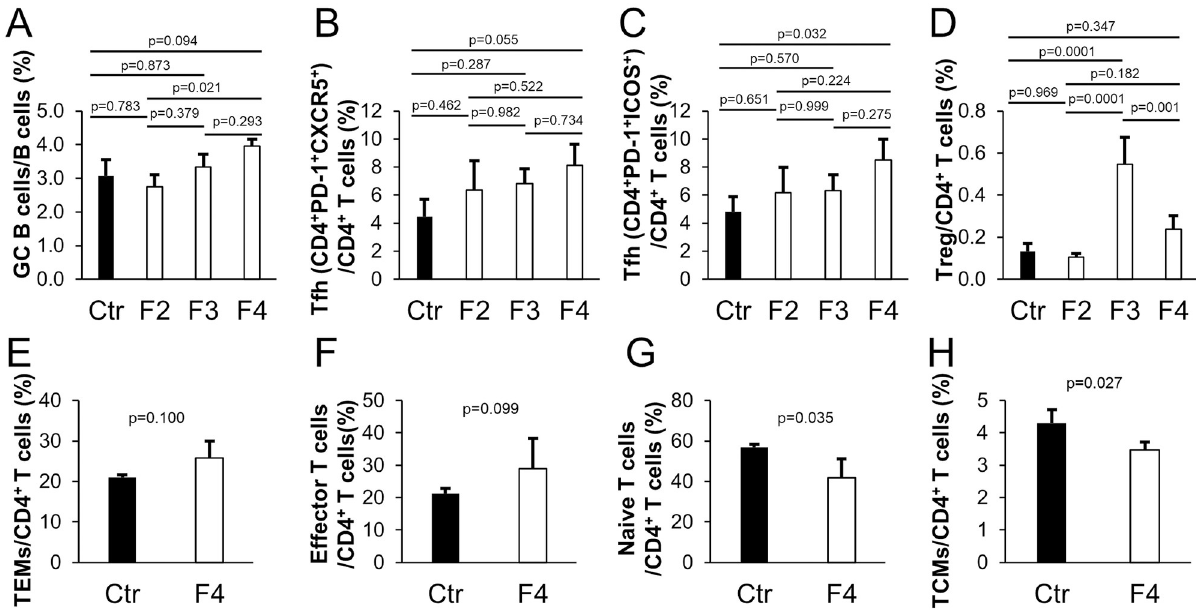
Fig 2. Intergenerational effects of T . halophilus No. 1 on B cells and T cells. We examined the proportion of B cell and T cell subsets in mice spleen. Flow cytometry plots are depicted in S3 Fig. (A) The proportion of GC B cells (B220 + GL7 + ) among B cells. (B) The proportion of Tfh cells (CD4 + PD- 1 + CXCR5 + ) among CD4 + T cells. (C) The proportion of Tfh cells (CD4 + PD-1 + ICOS + ) among CD4 + T cells. (D) The proportion of Treg cells (CD4 + CD127 − CD25 + CTLA4 + ) among CD4 + T cells. In (E)–(H), the proportion of subsets of CD4 + T cells in the F4 mice spleen was examined. The F3 generation data were used for the control. (E) The proportion of TEMs (CD44 high CD62L − ) among CD4 + T cells. (F) The proportion of effector T cells (CD44 low CD62L − ) among CD4 + T cells. (G) The proportion of naive T cells (CD44 low CD62L + ) among CD4 + T cells. (H) The proportion of TCMs (CD44 high CD62L + ) among CD4 + T cells. Bars indicate the mean ± SD. Based on the two-tailed Student’s t -test for two groups or the Tukey–Kramer test for four groups, the P-value was found to be relative to the control.